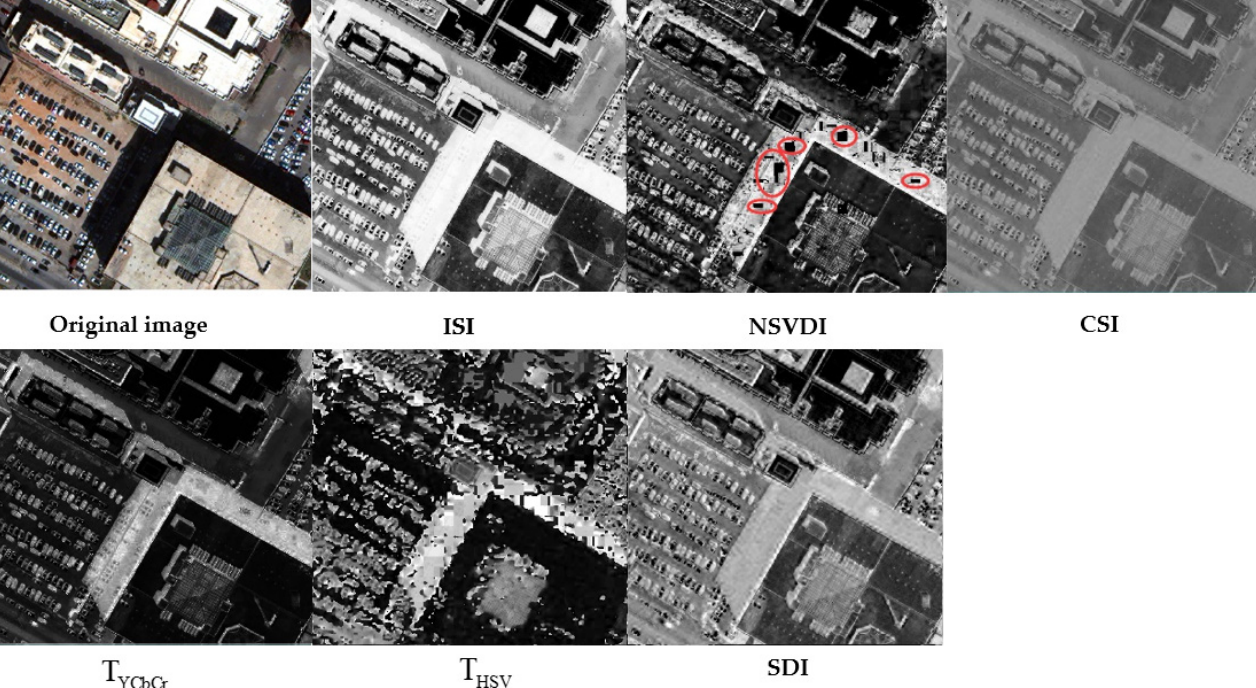
Figure 13. Enlarged details of each index result in Site 2: the area marked by the red ellipses in NSVDI are invalid values.